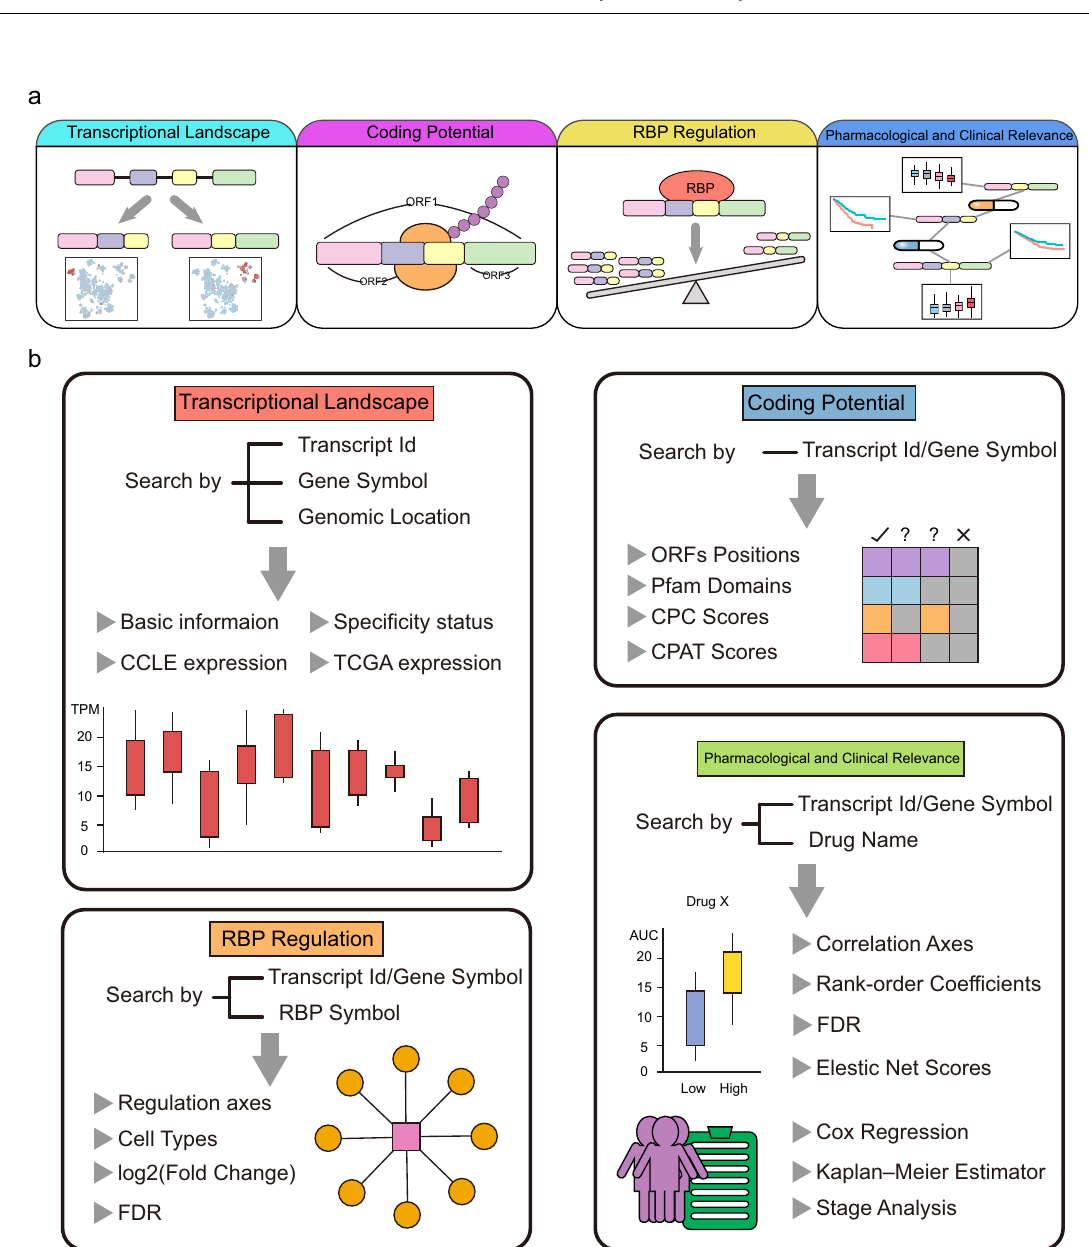
Fig. 6 | DiagramoftheTAiC data portal. a Overalldesign ofthe TAiCdataportal. b The full resource of TAiCisavailable to search, browse, visualize, and download. TAiC offers access to the transcriptional atlas of transcripts, coding potential of